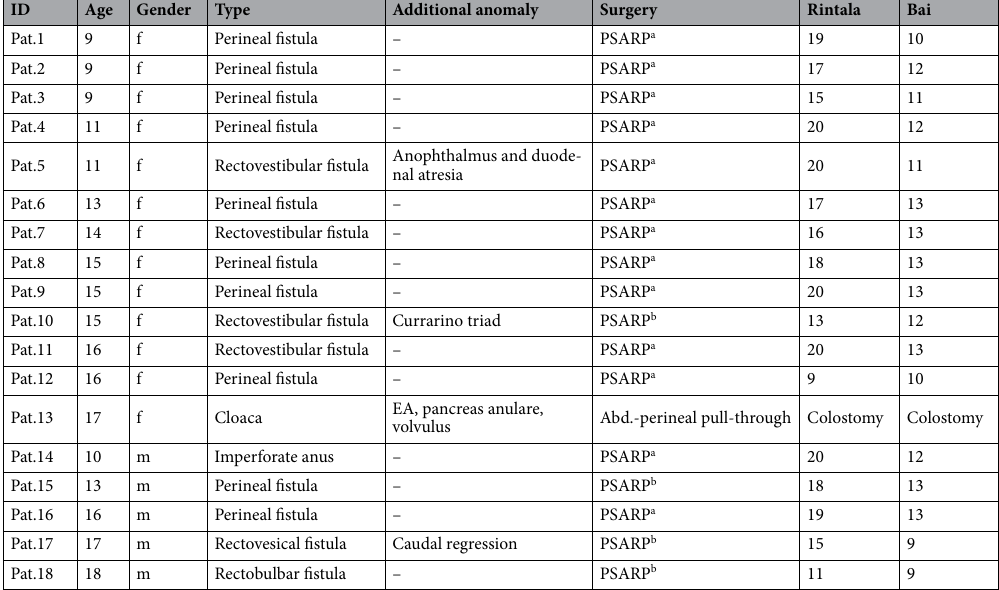
Table 1. ARM patients, age at time of follow-up, type of malformation, surgery, BFS according to Rintala 23 , QoL according to Bai et al. 4 and functional outcome. a One-staged procedure (PSARP). b Three-staged procedure (colostomy, PSARP, colostomy